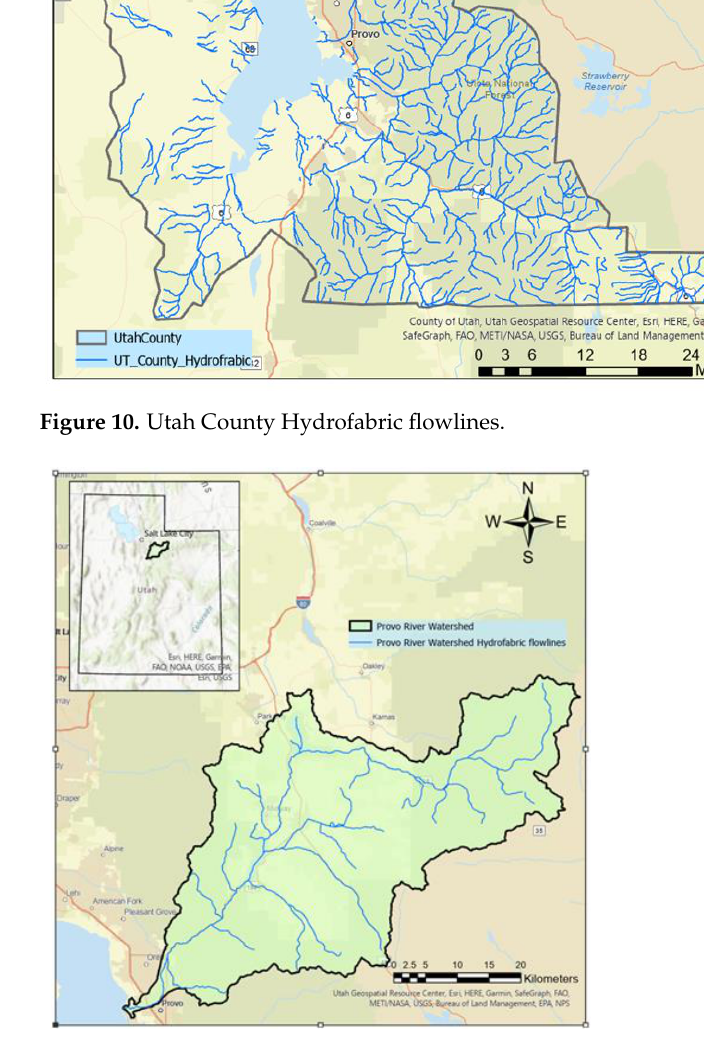
Figure 11. Provo River Watershed Hydrofabric and hand-delineated flowlines.